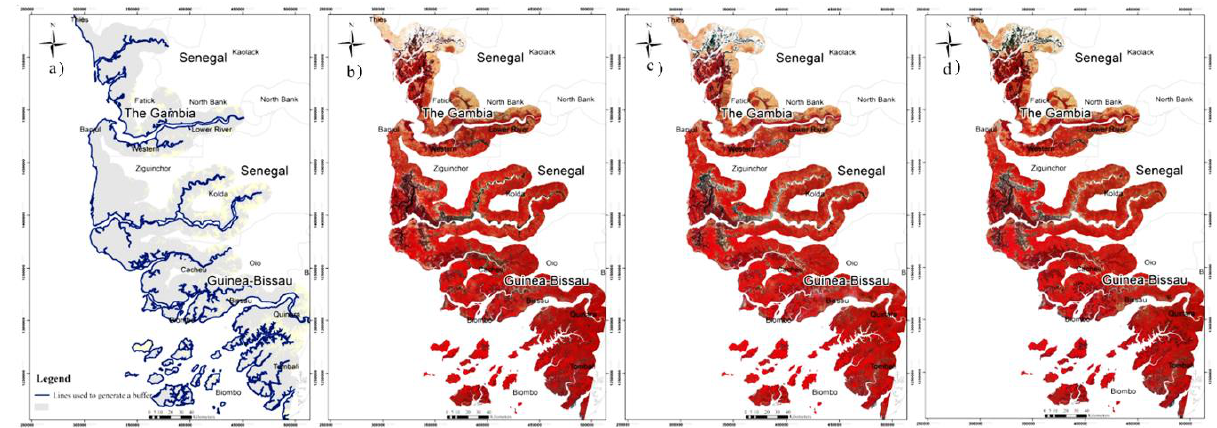
Figure 4. Study area after performing pre-processing and masking out non-vegetation area. a) Study area, b) Landsat image in 1988, c) Landsat image in 2001, and d) Landsat image in 2014 (band combination: R=NIR, G=R,